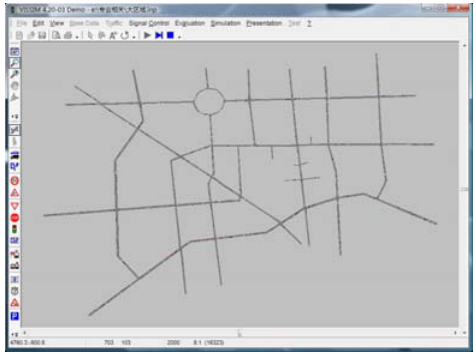
Fig. 7. Simulation network of